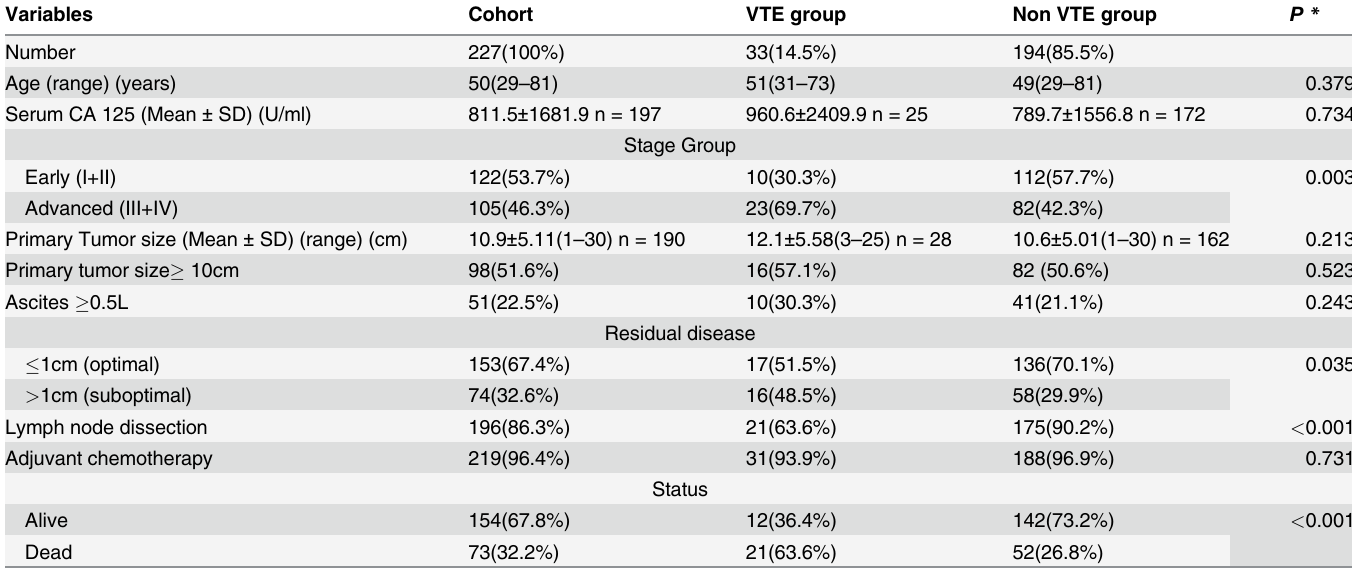
Table 1. Clinicopathological features of ovarian CCC patients with or without